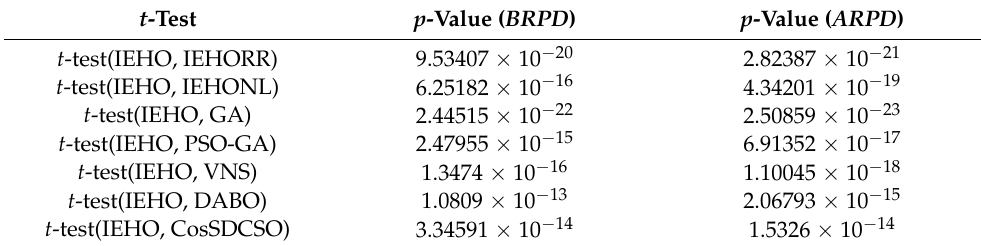
Table 10. The t -test results of paired